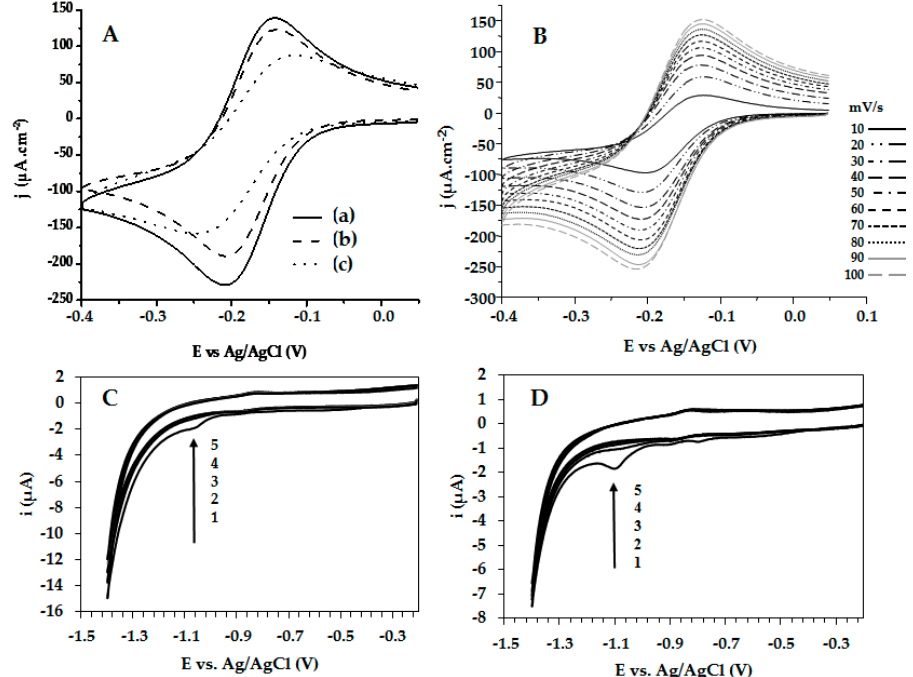
Figure 5. Cyclic voltammograms of the gold electrodes using a scan rate of 80 mV/s ( A ): bare Au (curve a), HPV-4|Au (curve b) and HPV-5|Au (curve c). Cyclic voltammograms of HPV-4|Au electrode at different scan rate ( B ). All measurements were performed in 1 mM Ru(NH 3 ) 6 Cl 3 in 0.50 M KCl at RT. Electrochemical desorption of HPV-4 ( C ) and HPV-5 ( D ) using 1, 2, 3, 4, 5, and 6 cyclic voltammograms in the presence of potassium hydroxide (0.5 M) at 20 mV/s.